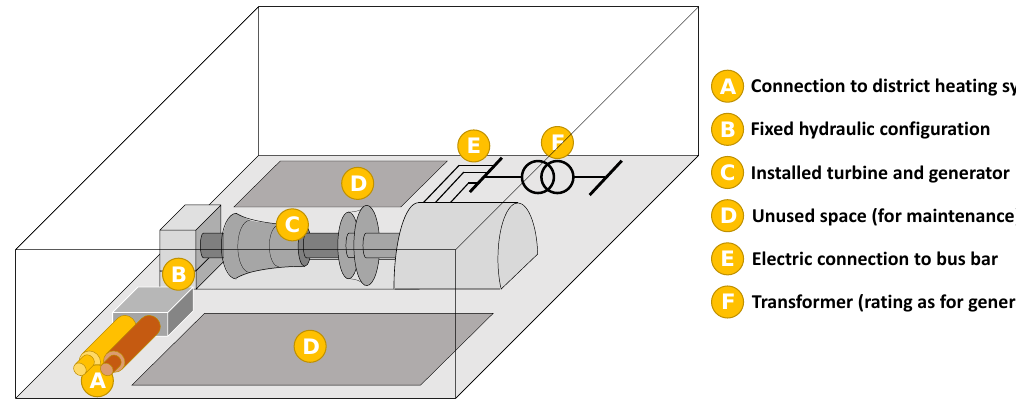
Figure 6. Typical combined heat and power generation based on a steam or gas turbine and a generator.